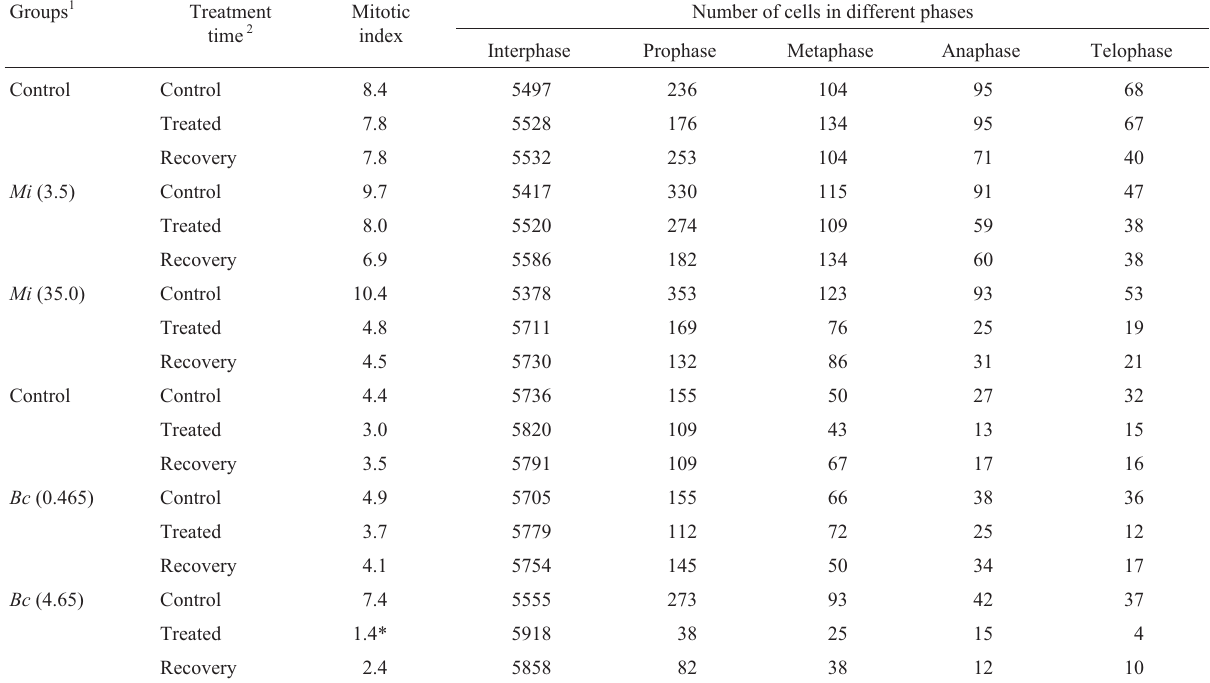
Table I - Mitotic index of onion root-tip cells treated with Maytenus ilicifolia ( Mi ) and Bauhinia candicans ( Bc ) infusions. Groups 1